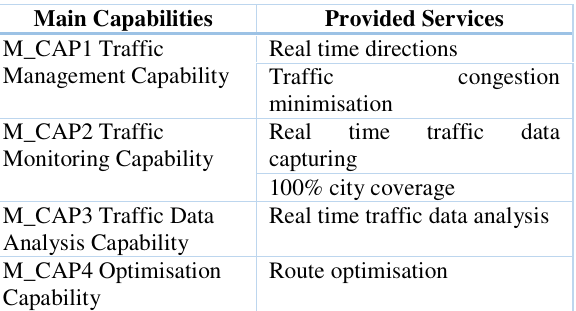
Table 1: Services delivered by main capabilities